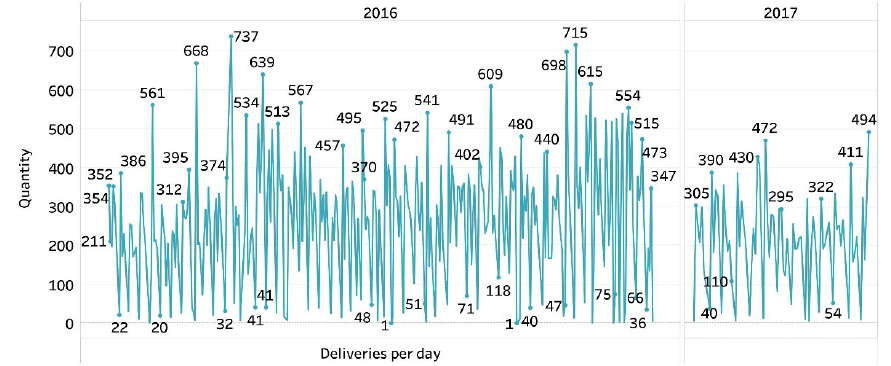
Fig. 1. Number of deliveries per day in Bogotá for 65 weeks